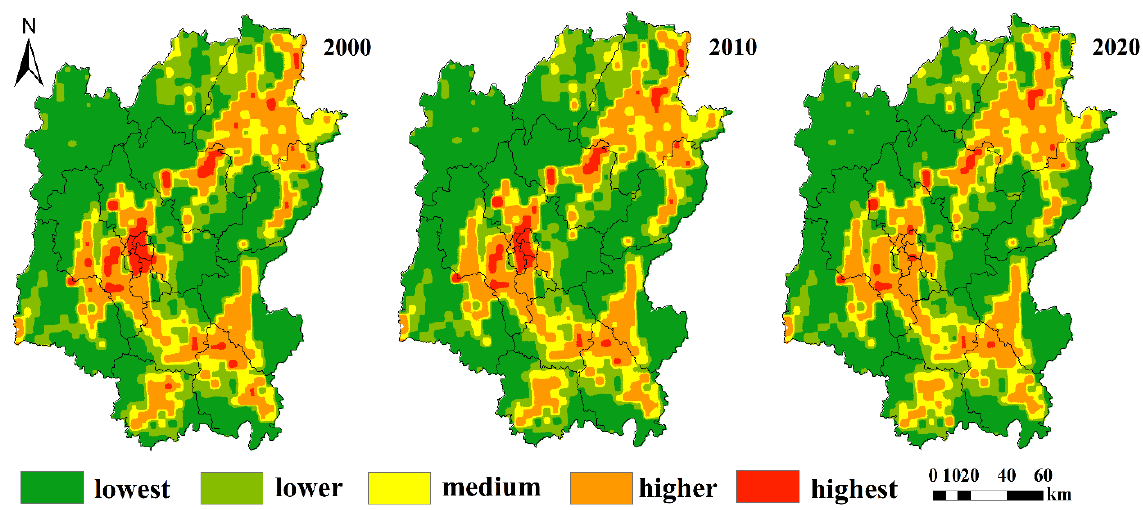
Figure 4. Spatial distribution of ecological risks in Guilin.